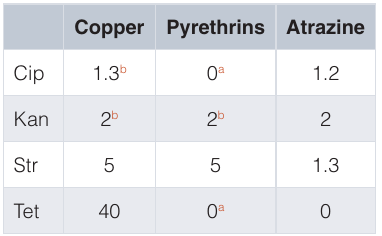
Table 3. Fold change shift in antibiotic effectiveness following exposure to biocides.